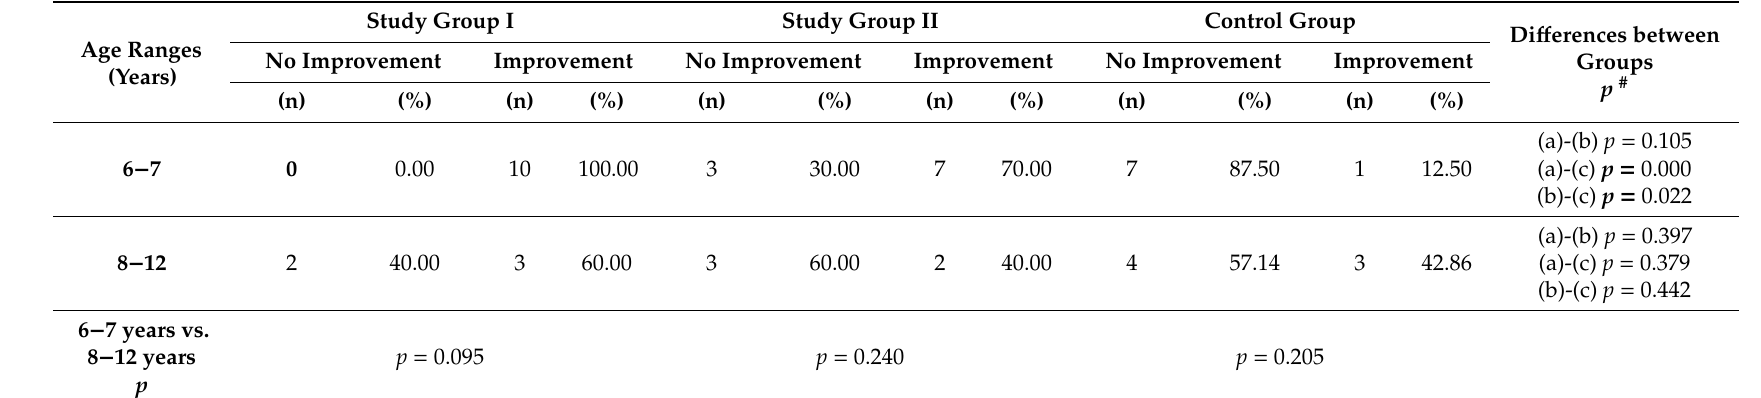
Table 5. Changes in the SAS scale assessment in terms of age (for two age ranges: 6 − 7 and 8 − 12